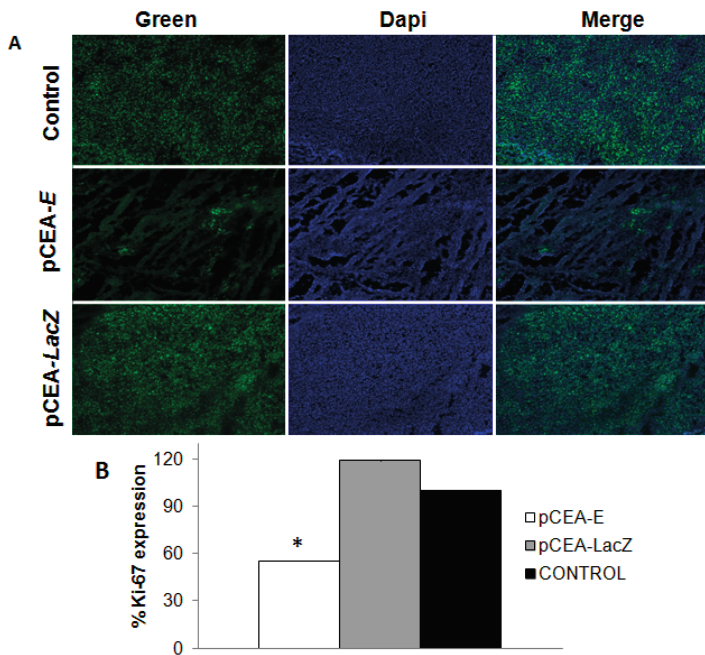
Figure 6. Immunohistochemical staining of Ki-67 expression in mice bearing subcutaneous MC-38 tumors treated with pCEA - E . ( A ) Images of Ki-67 expression (green) and cell nuclei stained with DAPI (blue). Original magnification: 10×; and ( B ) Ki-67 histogram protein expression profiles. Ki-67 expression was lower in the pCEA - E -treated group than in the pCEA - LacZ and control groups (* p < 0.05).